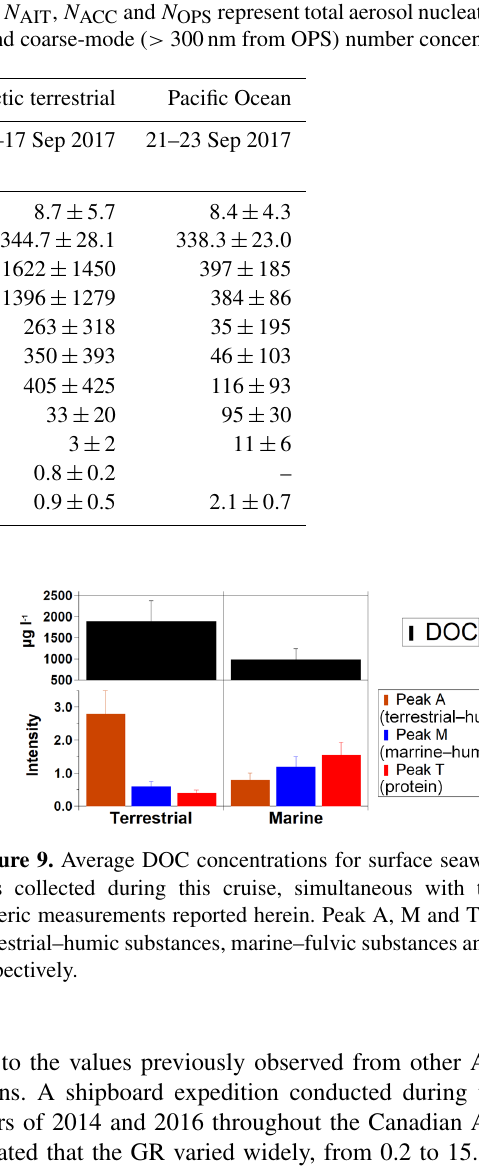
Table 1. A summary of meteorology, total number concentrations of particles (measured with TSI 3776 CPC, TSI 3772 CPC, standard SMPS, nano-SMPS), growth rate (GR) and condensation sink (CS) for the three selected periods. CN 2 . 5 and CN 10 represents the total number concentration of particles larger than 2.5 and 10nm, respectively. The N NUC , N AIT , N ACC and N OPS represent total aerosol nucleation-mode